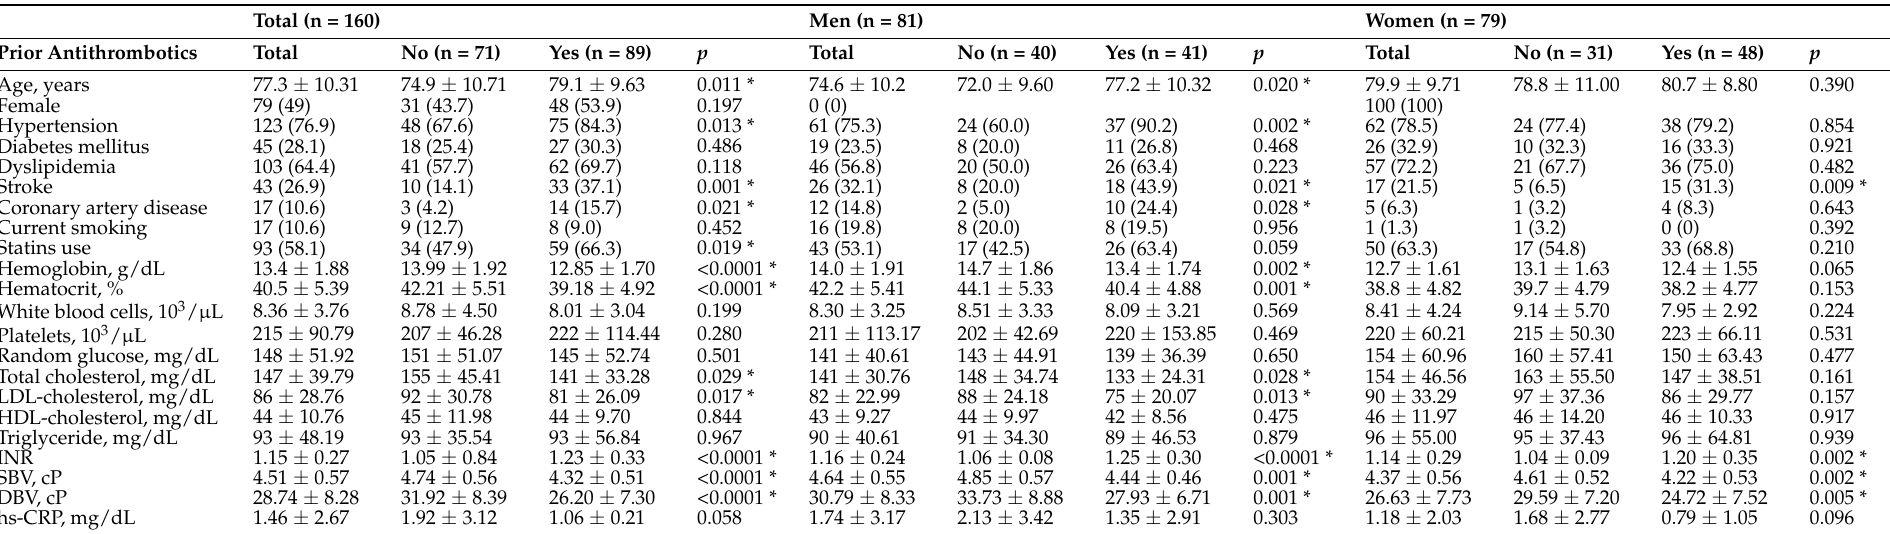
Table 1. The baseline characteristics of the enrolled